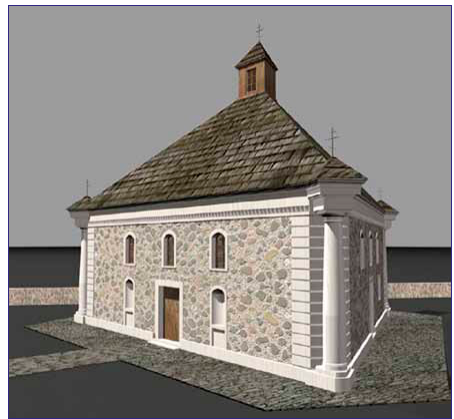
fig. 10. Svorotva Vialikaya. Holy Trinity uniate church (masonry), 1823. General view. Visualisation according to Sergachev 1992 and local vision of the state of repair. restitution: j. Czubiński. Visualisation: j. Tucholska,